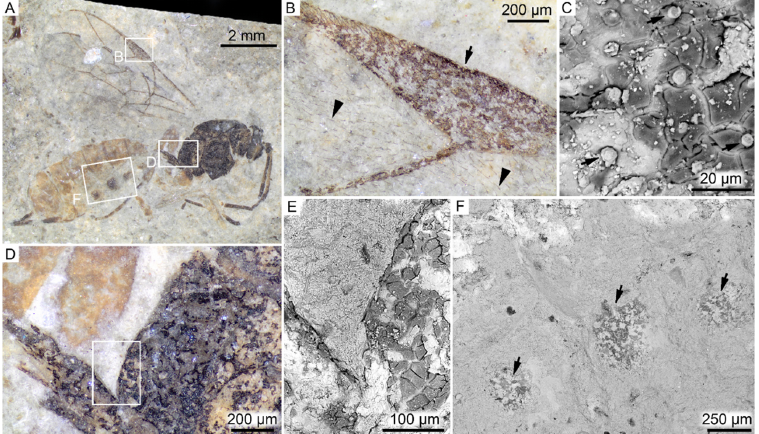
Figure 4. FUM-N-11263 (Hymenoptera). ( A ) Optical microscopy image of the fossil wasp with a dark thorax and head, and yellow-tinted abdomen and legs displayed in lateral view. ( B ) Higher magnification image showing brown pterostigma (arrow), a wing vein and the wing surface with abundant microtrichia (arrowheads). ( C ) SEM micrograph of inferred cuticular fragments in the pterostigma together with broken bristles (arrows). ( D ) Optical microscopy image of the narrow section joining the thorax and abdomen, displaying differences in preservation between the dark-colored matter and yellow-colored legs. ( E ) SEM micrograph of the area demarcated in ( D ) showing inferred cuticular remains. ( F ) SEM micrograph of the ventral side of the abdomen with carbonaceous spots (arrows) presumably representing relict cuticle.